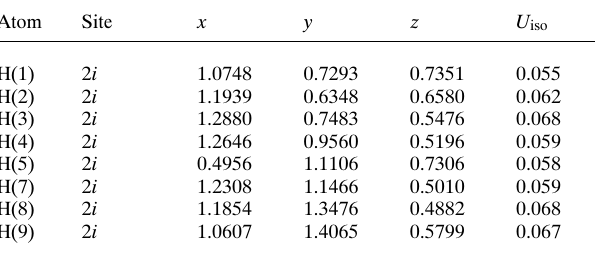
Table 2. Atomic coordinates and displacement parameters (in Å 2 ) .